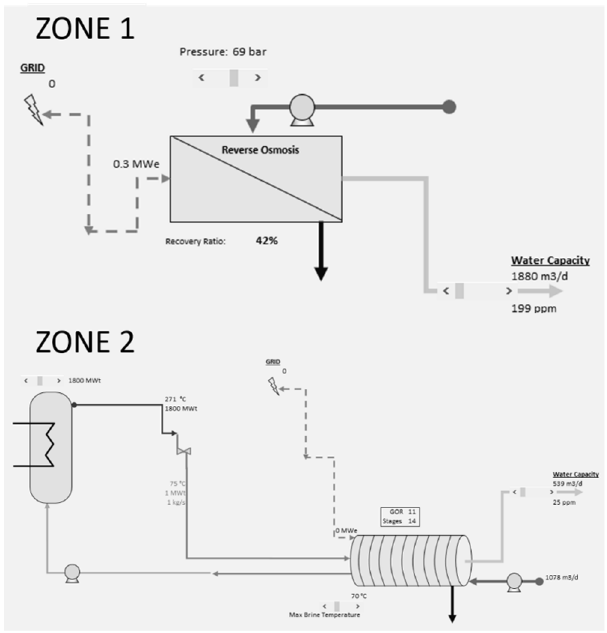
Figure 4. Water desalination flow diagrams.